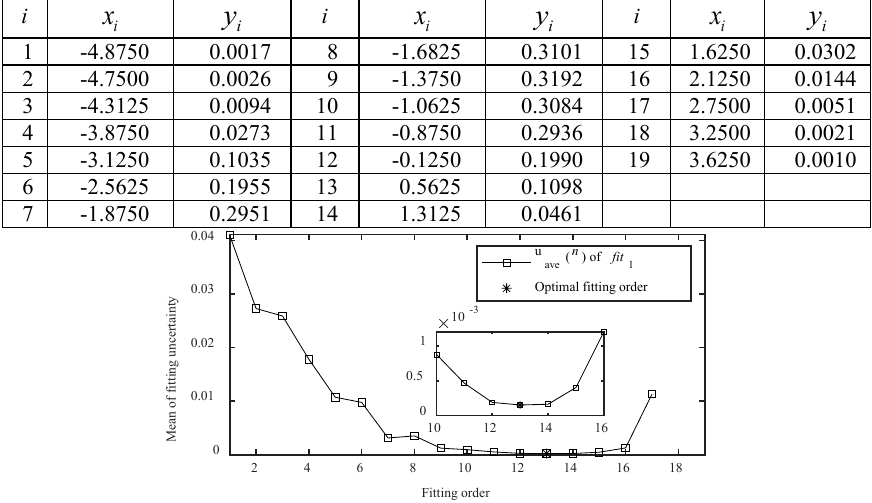
Fig. 2. Mean fitting uncertainties of fit 1 with different fitting